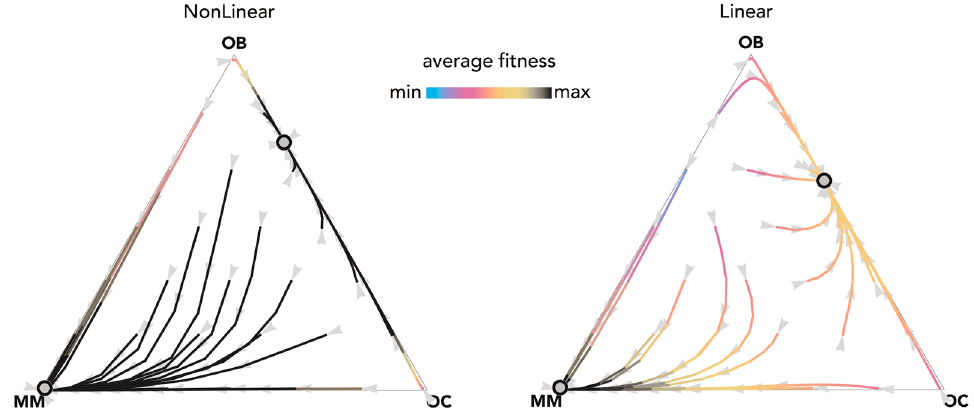
Figure 5. Nonlinear benefits and linear benefits can lead to similar dynamics. The distance from each vertex is inversely proportional to the frequency of each type. Arrows show the direction of the dynamics; colors show the average fitness of the population. N = 20; c OC = 0.1; c OB = 0.2; c MM = 0.3; B OC,OC = 0.55; B OC,OB = 1.1; B OC,MM = 0.6; B OB,OC = 1; B OB,OB = 0.5; B OB,MM = 0; B MM,OC = 0.8; B MM,OB = − 0.5; B MM,MM =